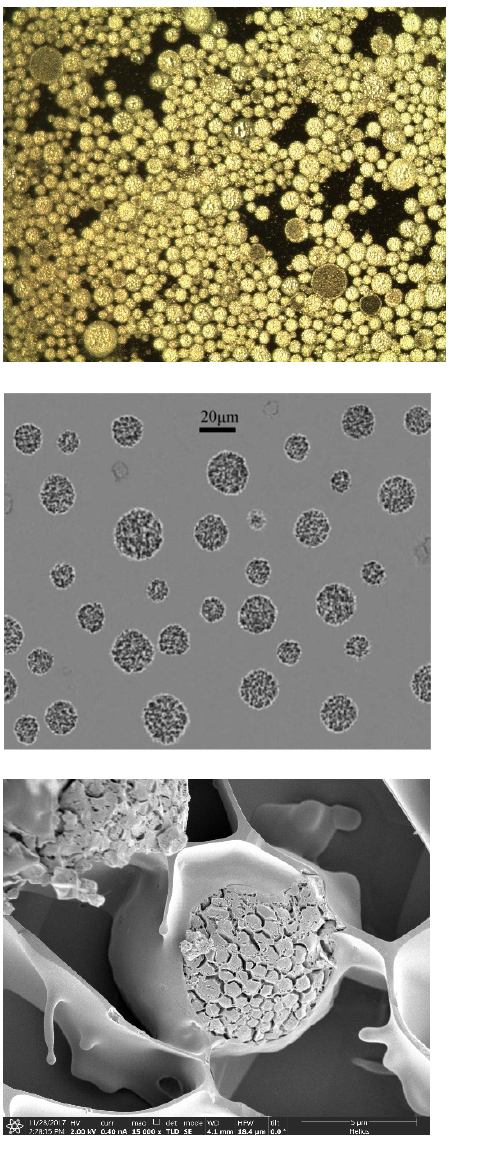
Figure 3. Optical microscopy (OM), confocal microscopy (CLSM), and transmission electron cryomicroscopy (cryo-EM) in multivesicular liposome (MVL)